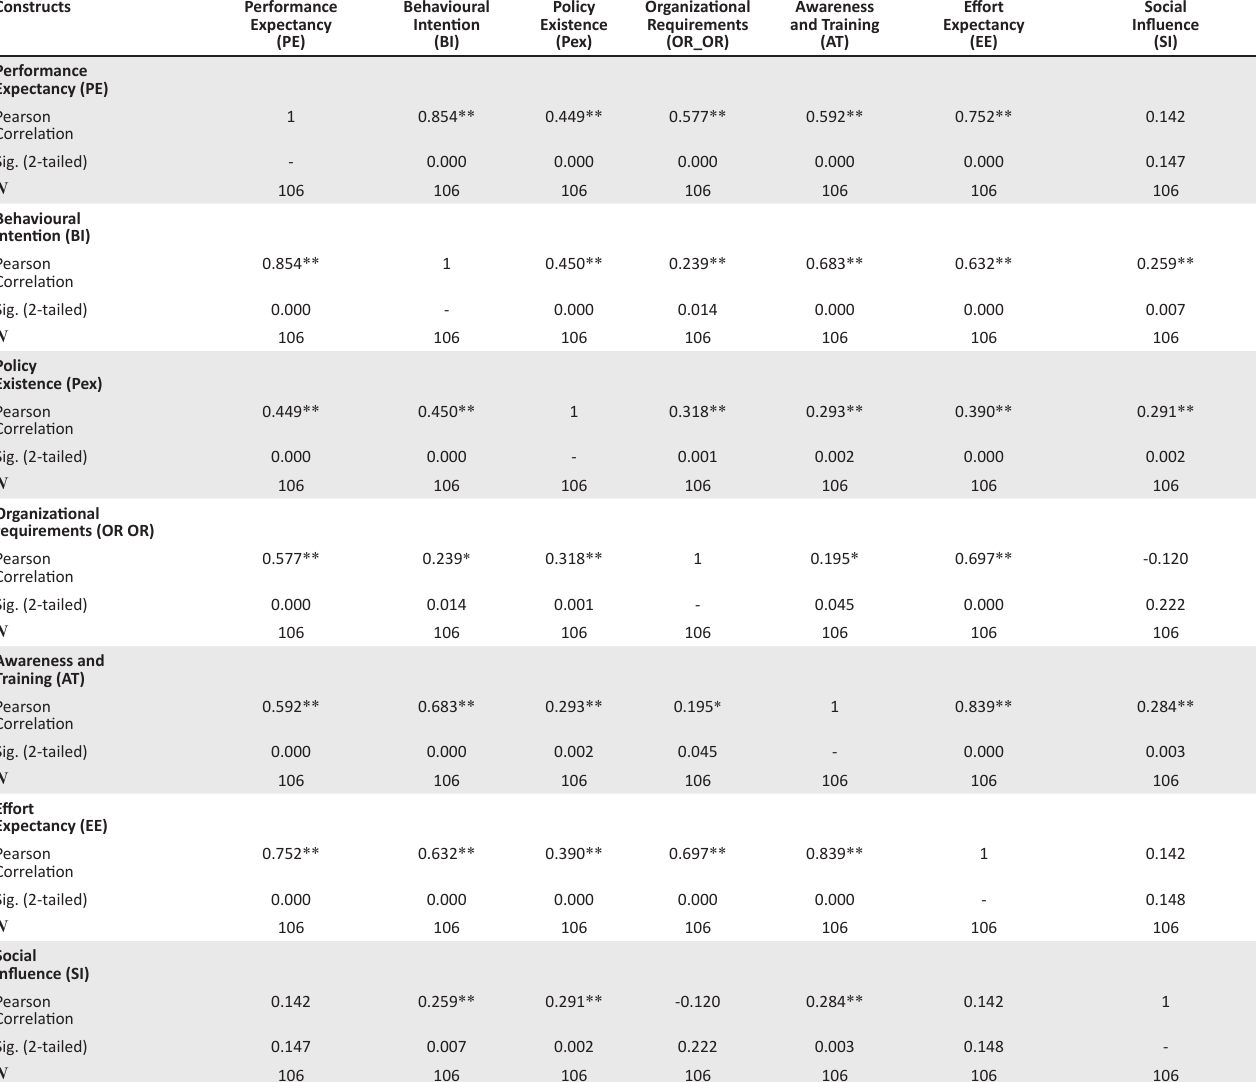
TABLE 2: Correlation analysis results.